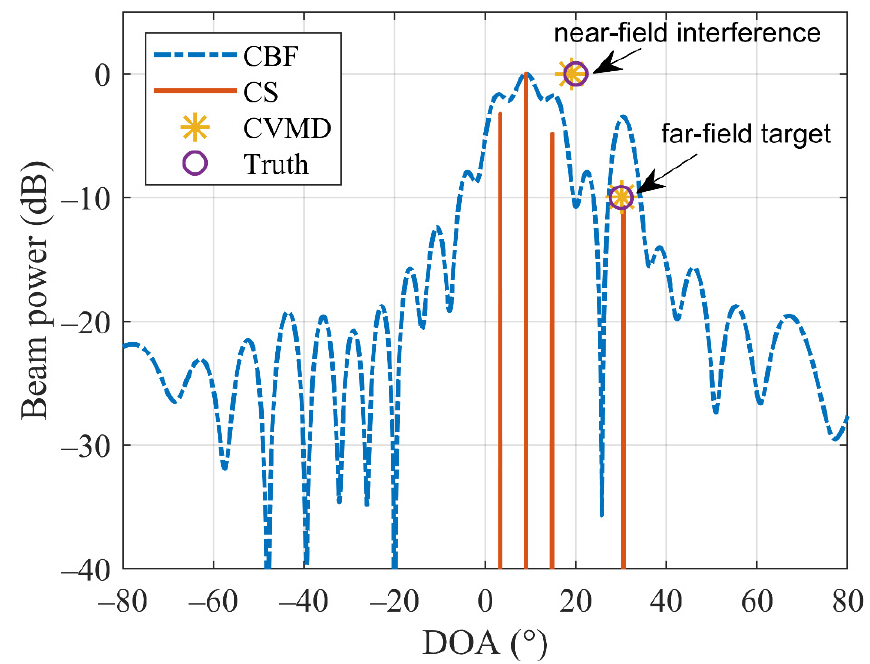
Figure 8. Far-field source DOA estimation in the presence of near-field interference by CBF, CS-based method, and CVMD-based method.